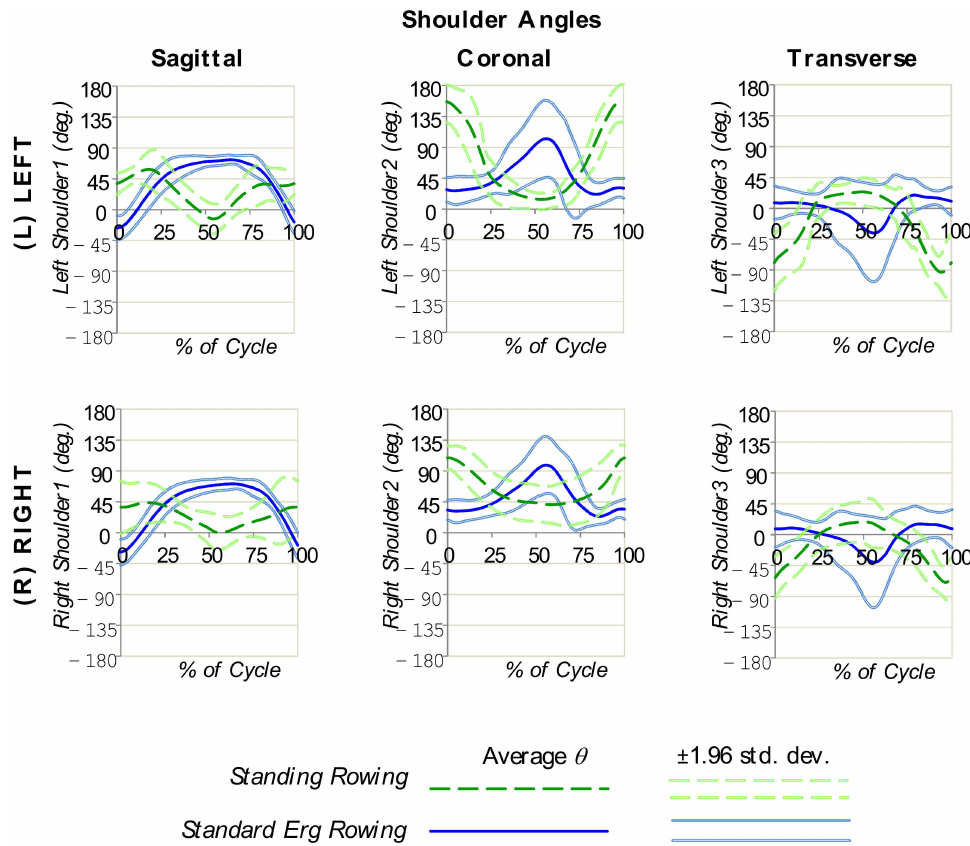
Figure 11. The averaged angular measurements for the shoulders from the laboratory study, reported as mean ± 1.96 s.d., which compares standing rowing (green) with standard ergometer sliding-seat rowing (blue).